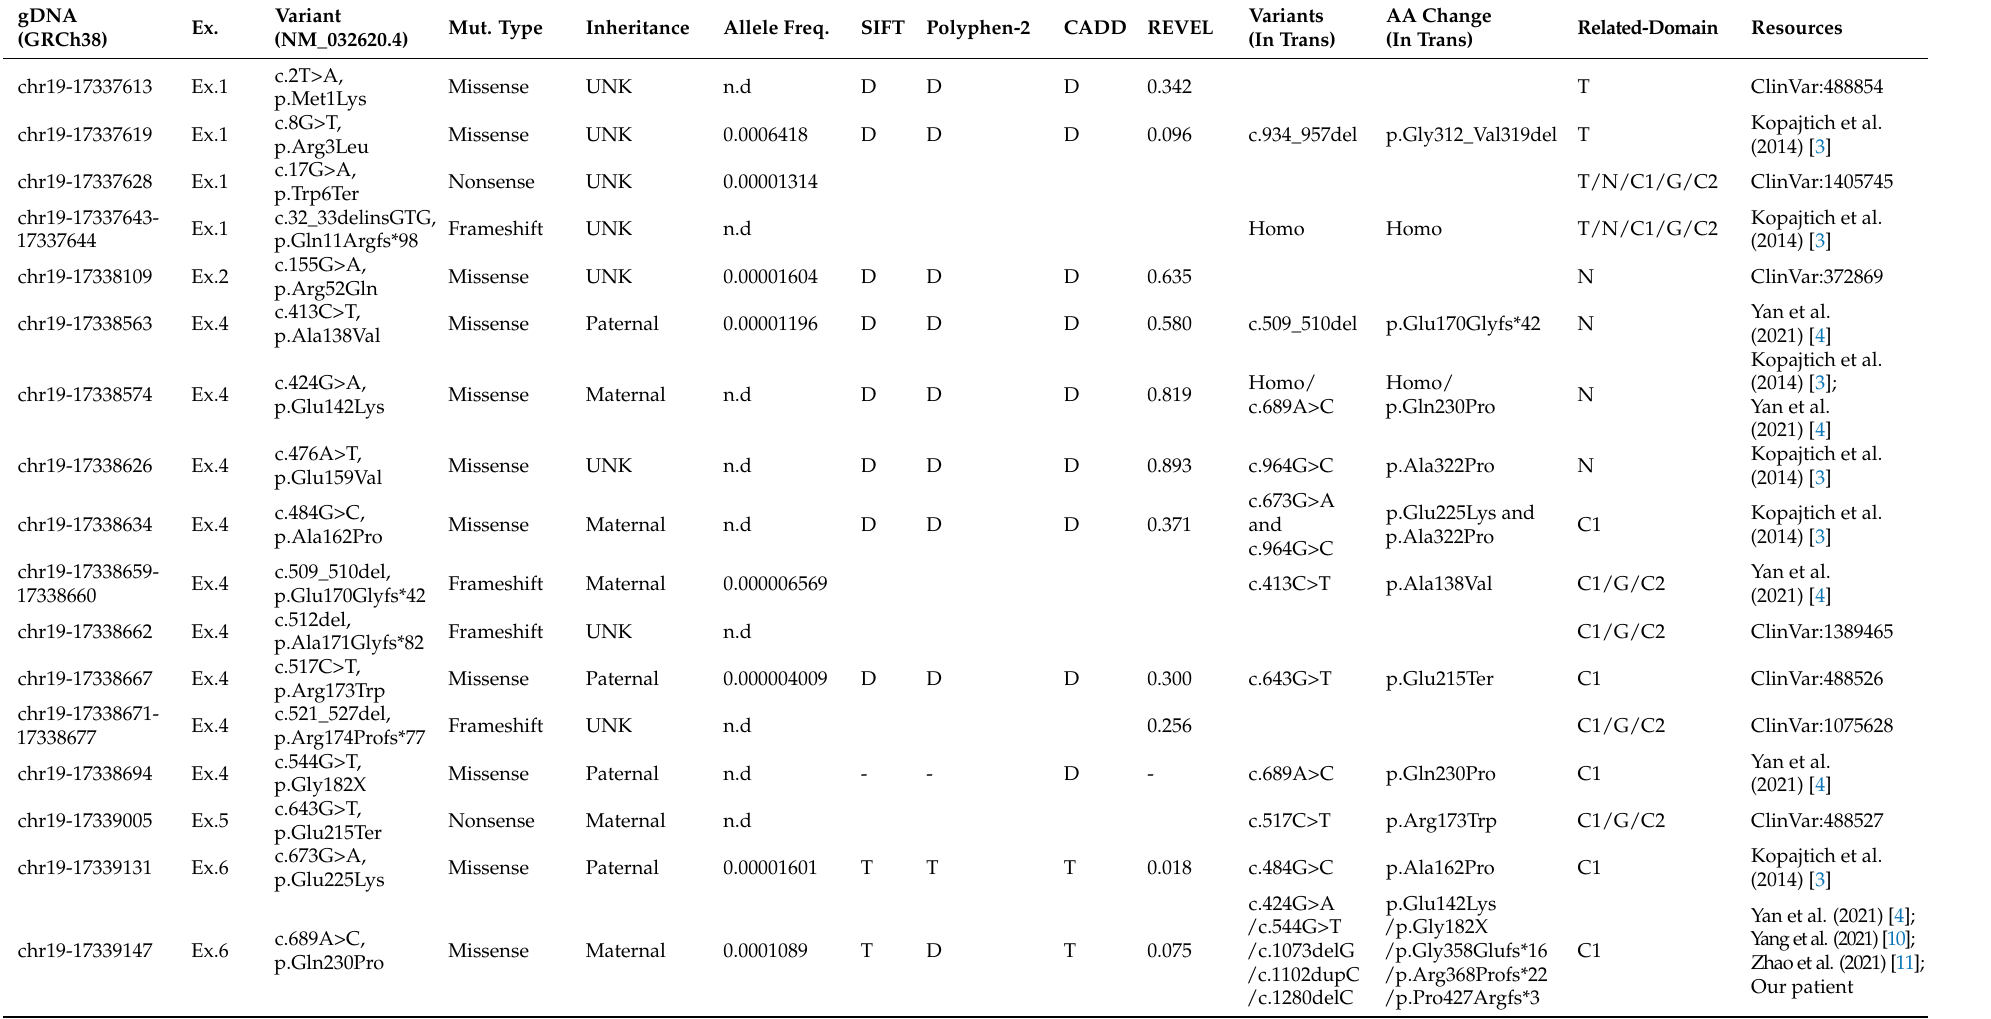
Table 1. Comprehensive analysis of 35 variants in